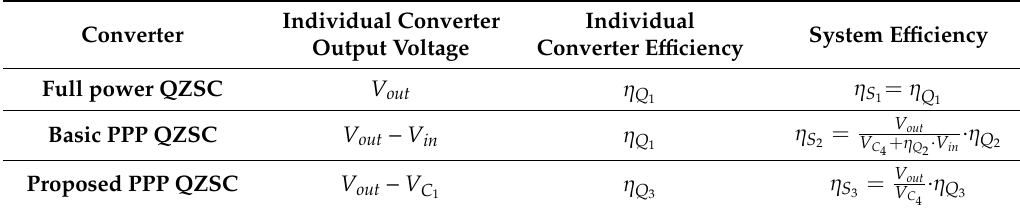
Table 3. E ffi ciency comparison of Full power, basic PPP, and proposed PPP Table 3. Efficiency comparison of Full power, basic PPP, and proposed PPP QZSC .